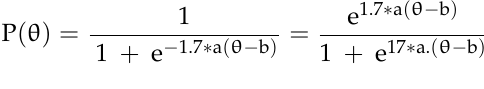
demic situation for a region), and difficulty (i.e., a location toward the left means the outbreak occurred at an earlier stage and to the right indicates the outbreak extended to a later stage). These two parameters were set between 0 and 4 (i.e., the slope) and − 5 and 5,